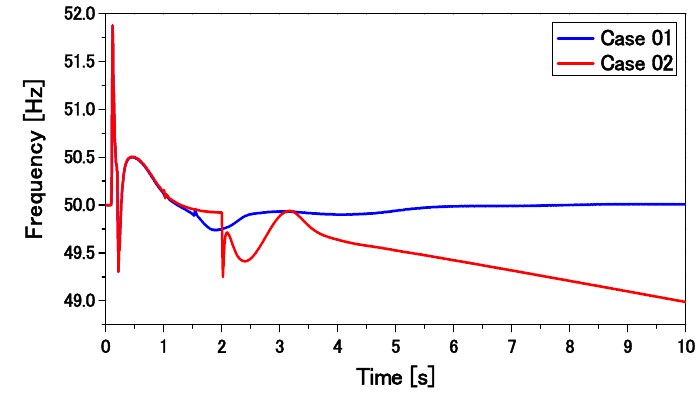
Figure 29. Individual responses of conventional SGs: ( a ) active power; ( b ) rotor speed.